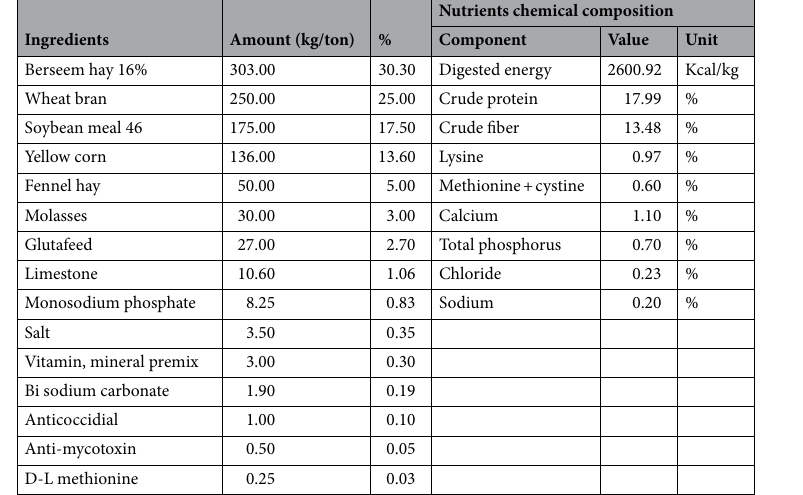
Table 1. Ingredients and nutritional composition of basal diet.